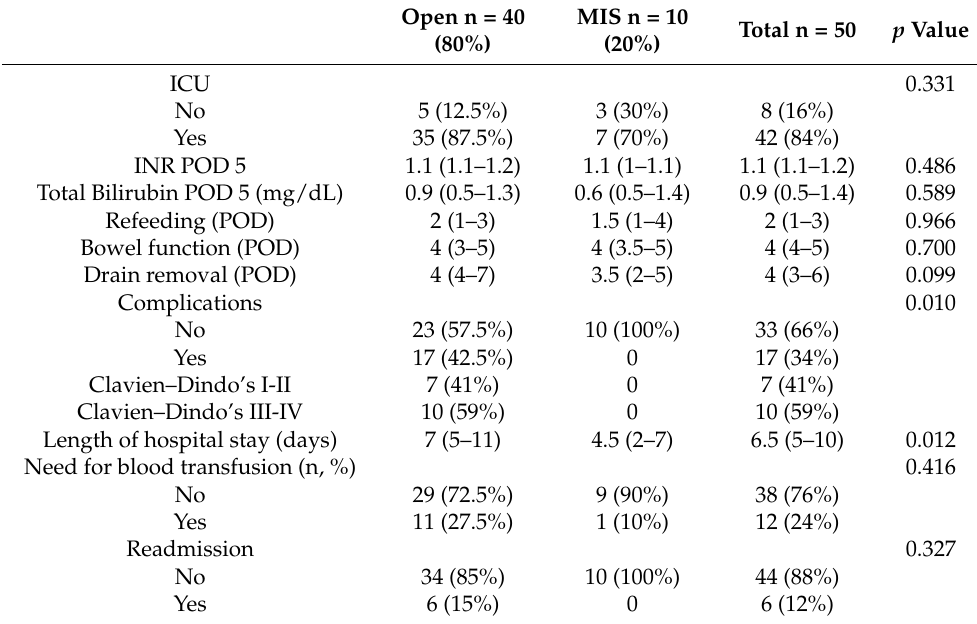
Table 4. Postoperative results.